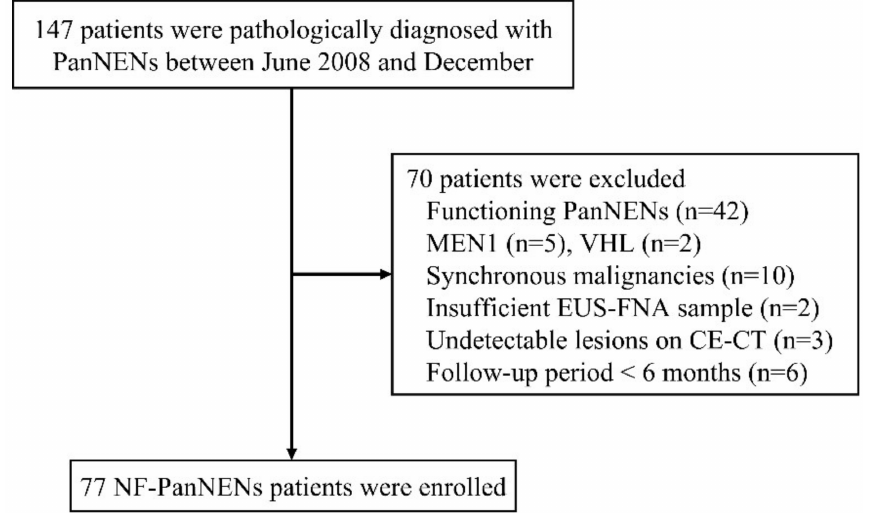
Figure 1. Flowchart of patient